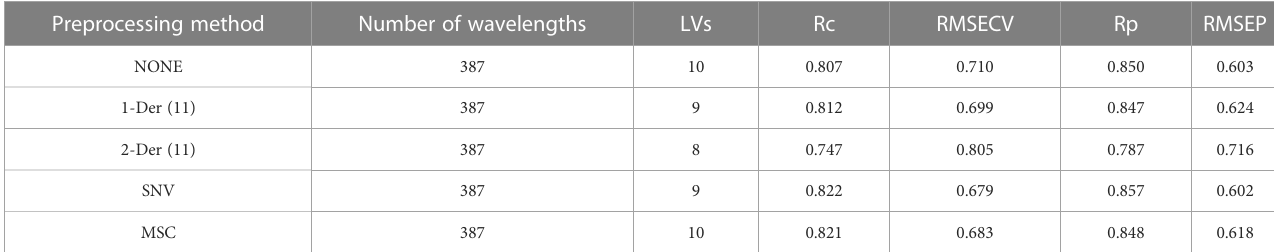
TABLE 2 Performance of model based on the different preprocessing methods for measuring LC of batch A of samples. Preprocessing